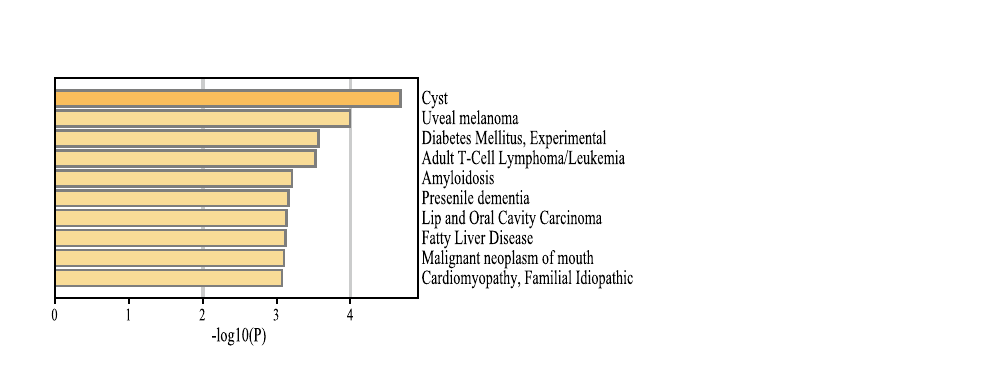
Figure 8. The process of identifying comorbidities in